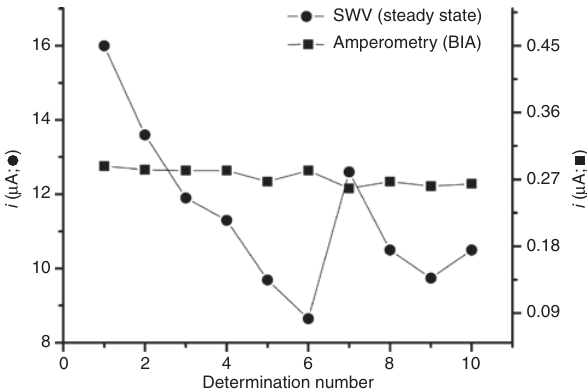
Figure 10: Current data over 10 runs of a solution of diclofenac using square wave voltammetry (steady-state conditions; •) and batch injection analysis with amperometry ( ■ ). Reproduced with permission from Tormin et al.